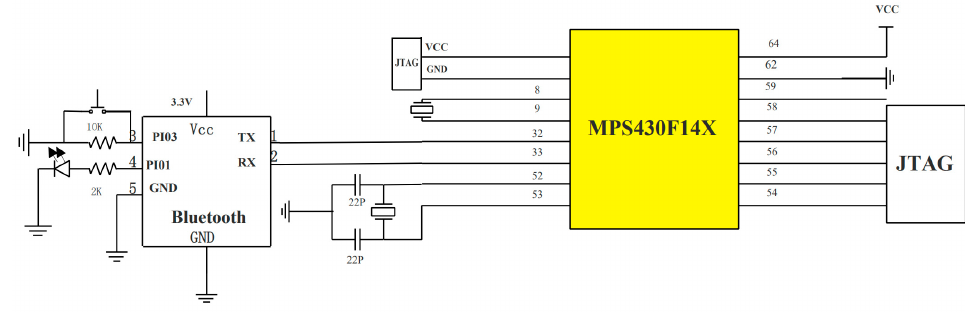
Figure 3. The connections and circuits of MSP430F149.